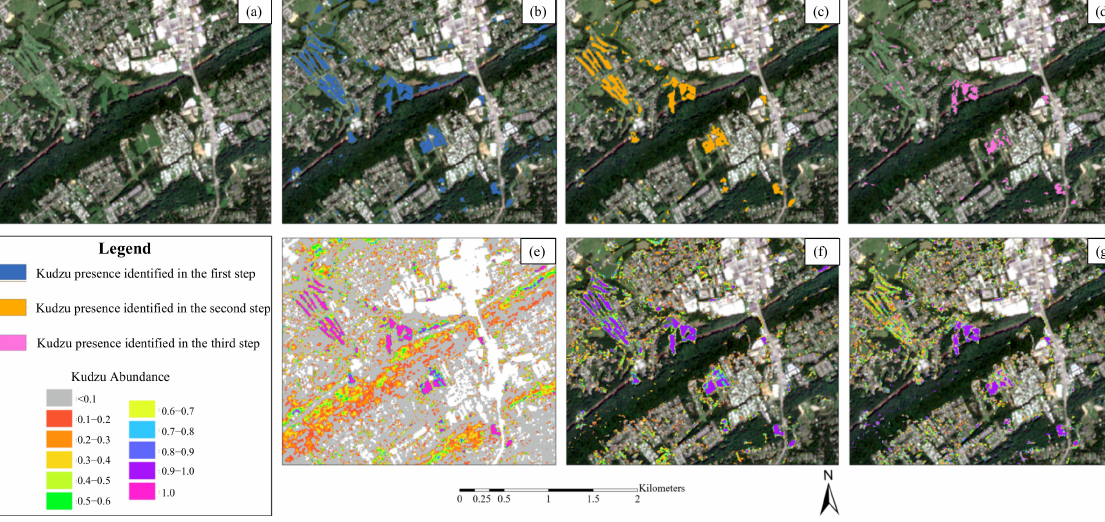
Figure 12. Misclassification of small grassland patches over the three steps: ( a ) true color composite image; ( b – d ) kudzu presence identified from steps 1 to 3, respectively; ( e – g ) kudzu abundance identified from steps 1 to 3,